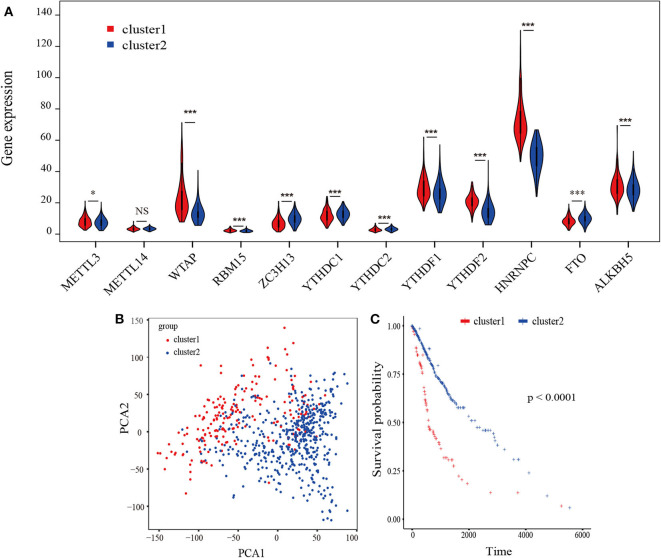
Identification of consensus clusters by m6A RNA methylation regulators overall survival of gliomas in the cluster 1/2 subgroups. (A) Violin plot of the two clusters (cluster1/2) defined by the m6A RNA methylation regulators consensus expression. (B) Principal component analysis of the total RNA expression profiles in the TCGA-GBM/LGG datasets. Gliomas in the cluster1 subgroup are marked with red. (C) Kaplan–Meier overall survival (OS) curves for 665 TCGA glioma patients of different cluster. *P < 0.05; **P < 0.01; ***P < 0.001; ****P < 0. 0001.